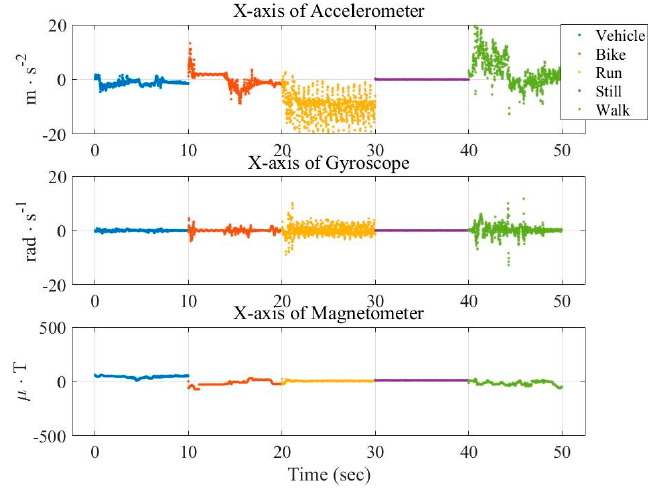
Figure 1. Distribution of raw data from three sensors (x-axis) in the transportation mode.